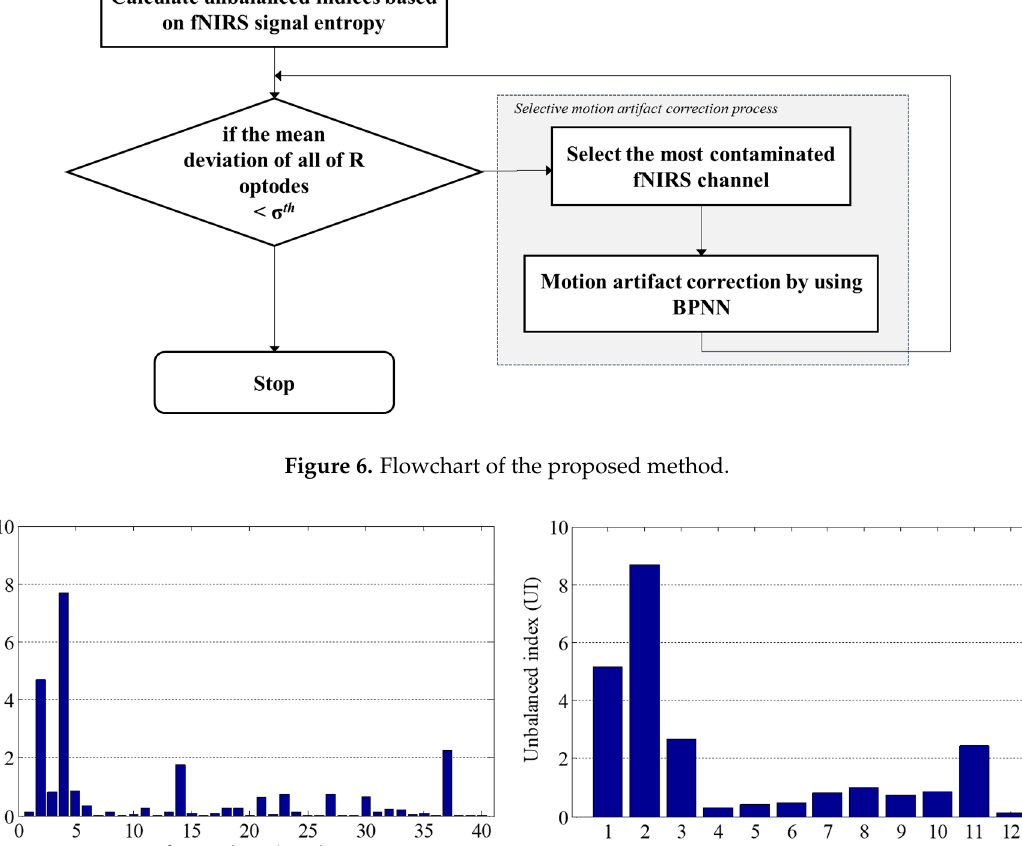
Figure 7. Contaminated optode identification: ( a ) UD for all of the fNIRS channels; ( b ) UI for all of the R-optodes.